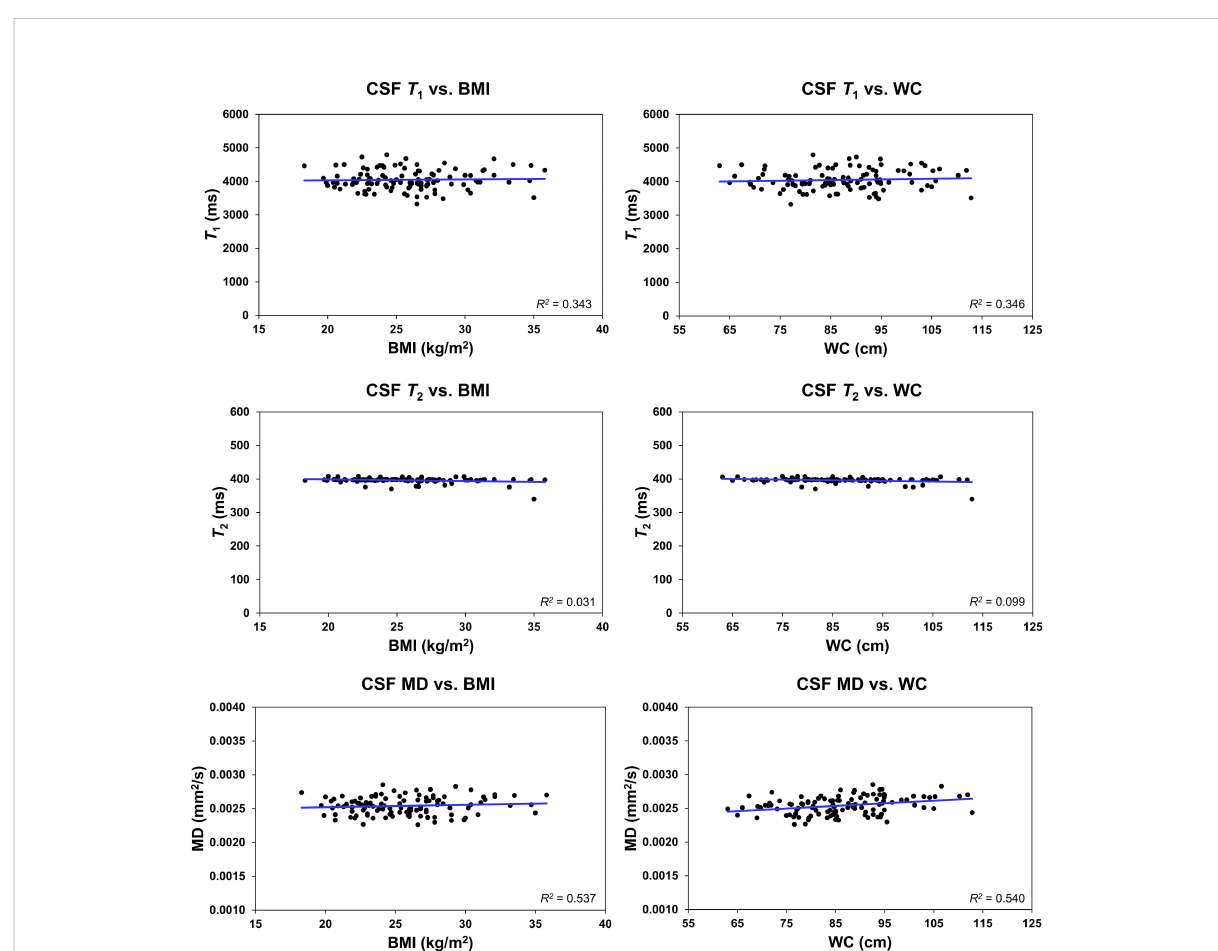
FIGURE 5 Regression results ( n = 113) for the relationship between T 1 , T 2 , or mean diffusivity (MD), derived in the ventricular cerebrospinal fl uid (CSF), and body mass index (BMI) or waist circumference (WC), adjusted for age, age 2 , sex, and ethnicity. The coef fi cient of determination, R 2 , is reported. All associations were statistically nonsigni fi